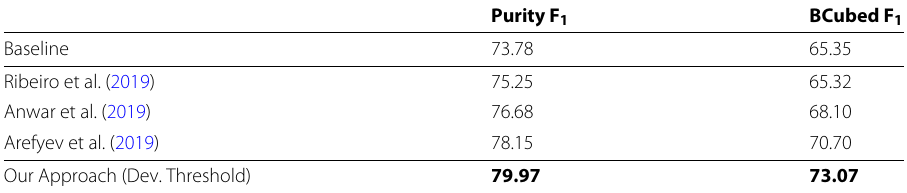
Table 11 Comparison of semantic frame induction results with those of previous approaches in terms of performance on the test data